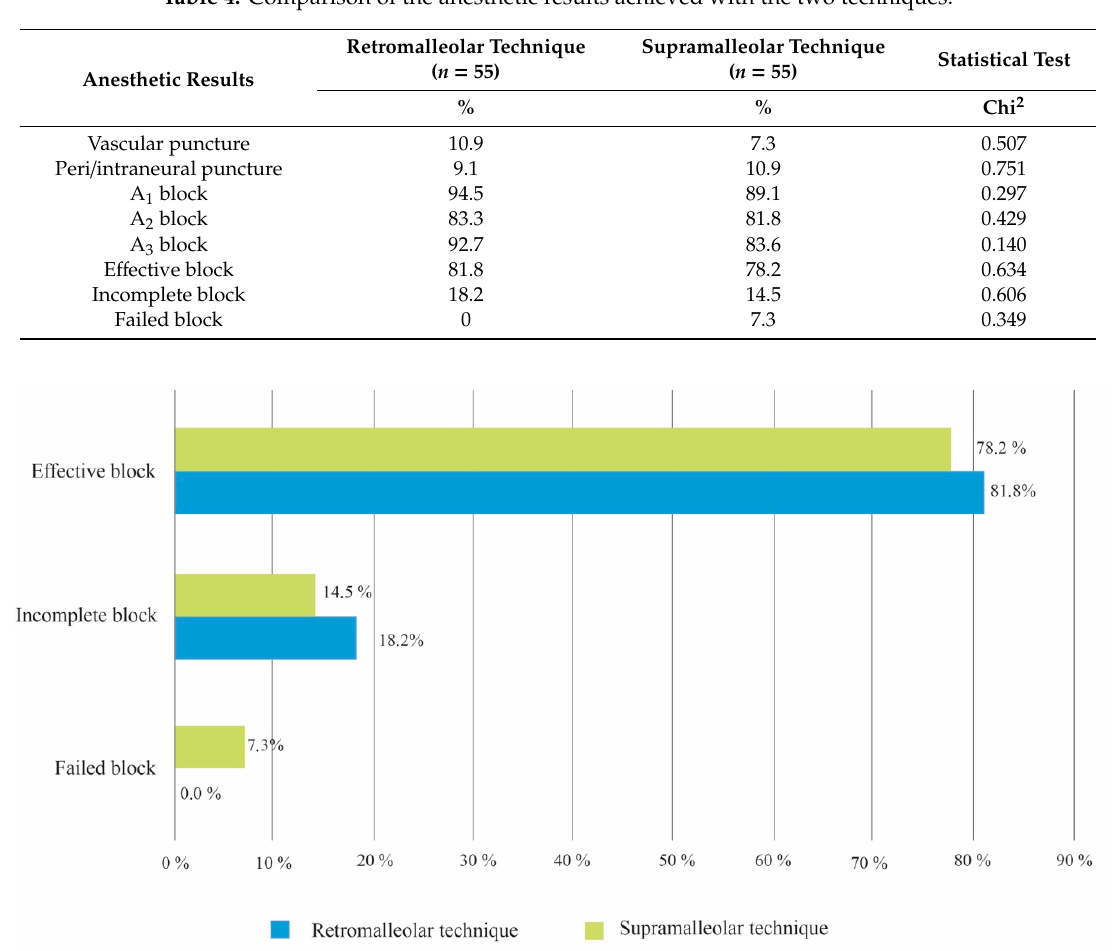
Figure 6. Comparison of the percentage of effective blocks based on the latency time for each of the areas and anesthetic techniques.